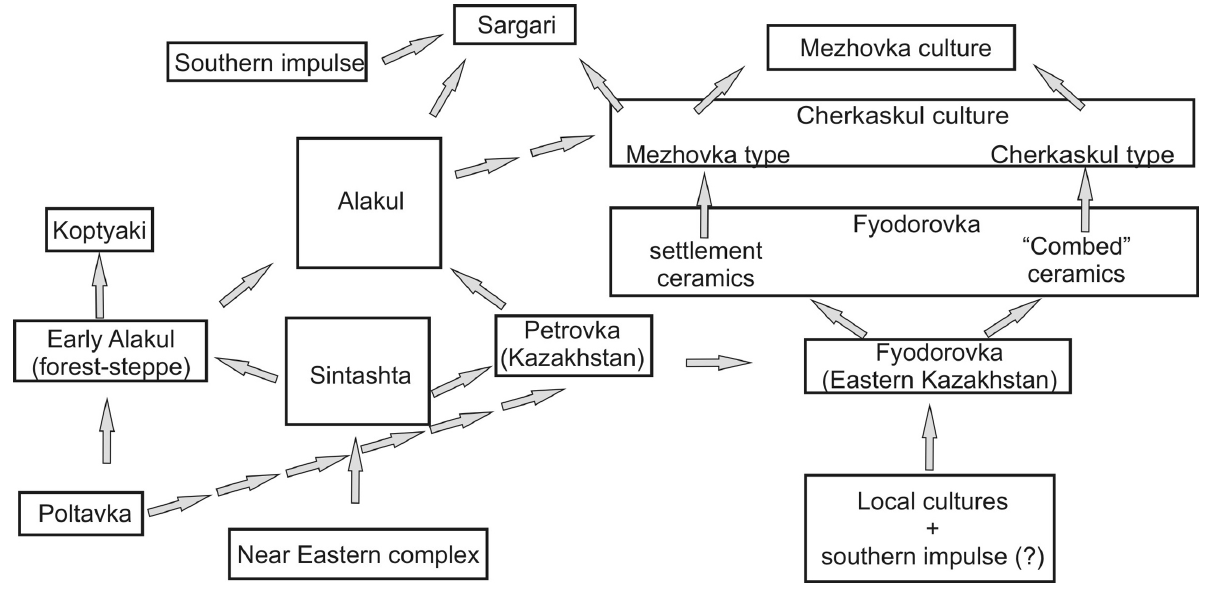
Figure 25: Scheme of cultural genesis in the Bronze Age in the Southern